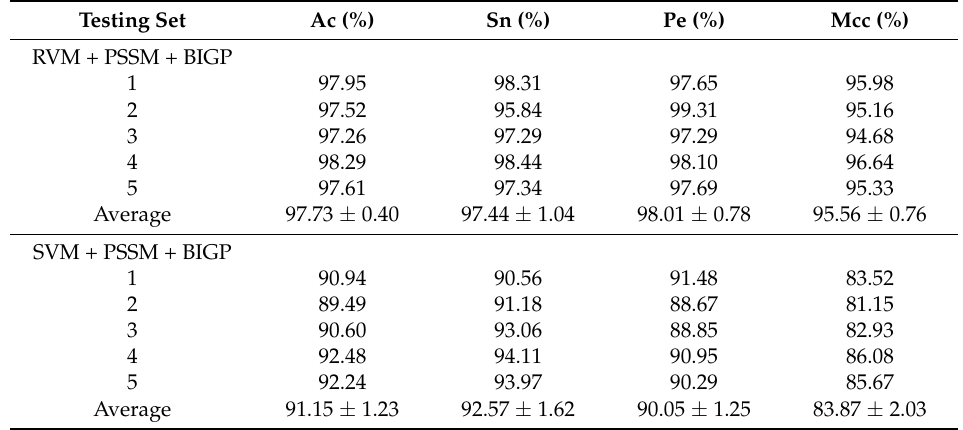
Table 5. 5-fold cross validation results performed by SVM and RVM classifiers on an enzyme dataset. Testing